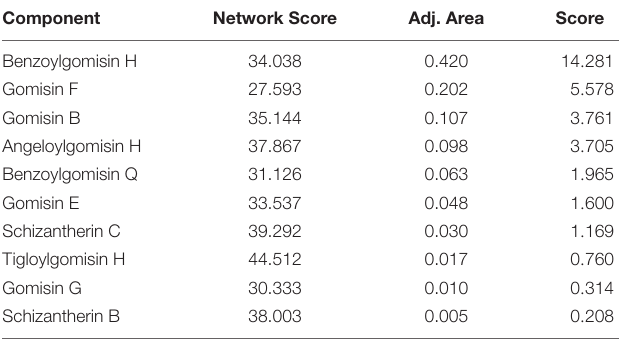
TABLE 3 | Predicted score of the Schisandra components in the treatment of AMI. Component Network Score